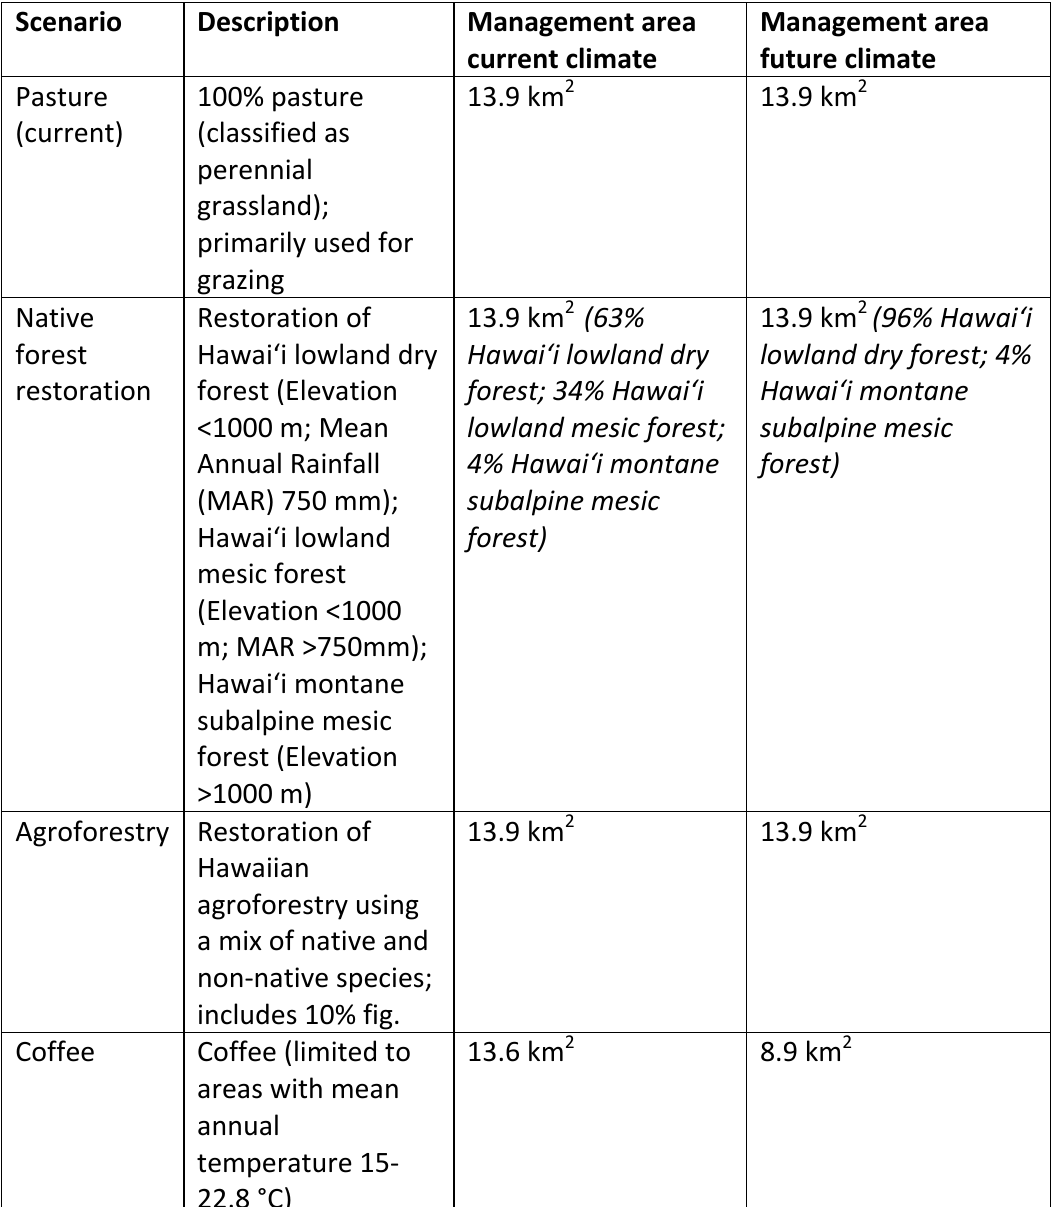
Table A1.1. Land-use scenarios developed for the current pasturelands of Kaʻūpūlehu,